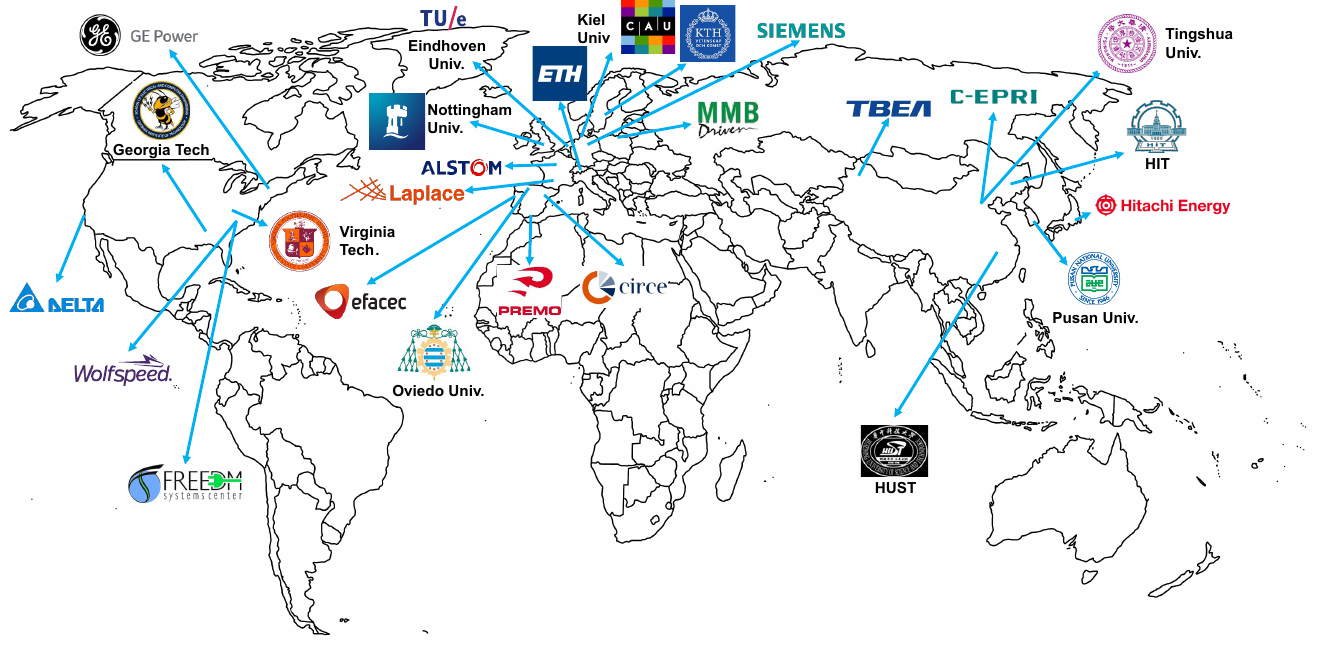
Figure 15. Identified stakeholders that have published a SST prototype having relevant features, namely, not a scaled-down prototype and with rated power higher than 25